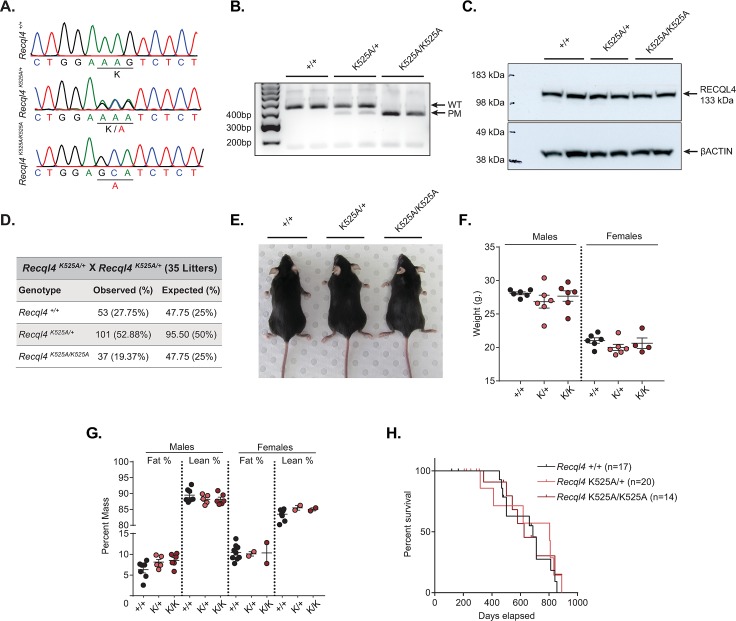
Homozygous and heterozygous helicase-dead mice are viable, have normal body weight and composition, and normal long-term survival.(A) Sequencing traces of the WT, heterozygous and homozygous K525A mutation. Altered nucleotide and amino acid changes are indicated above the sequence trace. (B) Genomic DNA PCR of Recql4+/+, Recql4K52A/+, Recql4K525A/K525A. 2 different mice per genotype. (C) Western blot of thymocyte lysates from Recql4+/+, Recql4K52A/+, Recql4K525A/K525A 10 weeks old mice probed with anti-Recql4 (clone 3B10; top). The same blot re-probed with anti-β-Actin (bottom). (D) Breeding data from 35 litters of Recql4K52A/+ intercrosses. Observed and expected mendelian rates of the indicated genotypes are shown. No statistical significance was achieved. (E) Representative photograph of male Recql4+/+, Recql4K52A/+, Recql4K525A/K525A mice. (F) Gross body weights of 10-week old male and female Recql4+/+, Recql4K52A/+, Recql4K525A/K525A mice. (G) Echo-MRI analysis of fat and lean percentage at 10 weeks of age from male and female Recql4+/+, Recql4K52A/+, Recql4K525A/K525A mice. (H) Kaplan-Meier survival plots of the indicated genotypes. K = K525A.